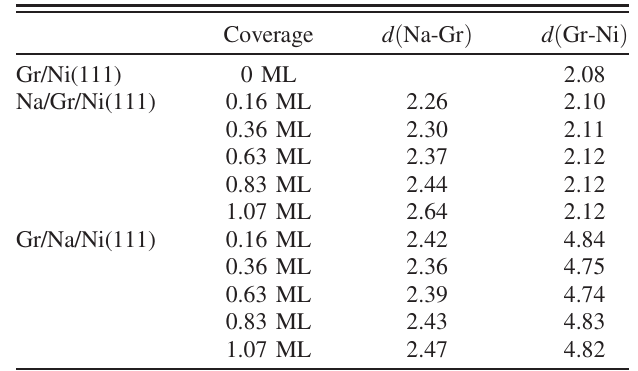
TABLE I. Structural details of the graphene/Ni(111), Na/ graphene/Ni(111), and graphene/Na/Ni(111) surfaces. d ð Å Þ rep- resents the interlayer spacing between two species. Here, the layer spacing is averaged over all atoms in the layer.